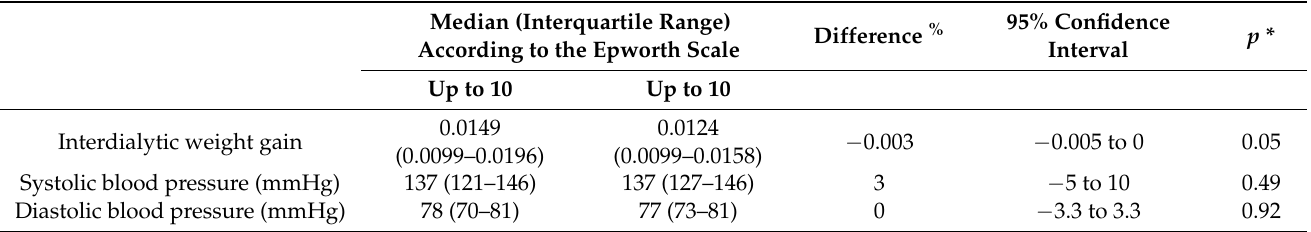
Table 6. Differences in interdialytic weight gain and blood pressure in comparison with daytime sleepiness